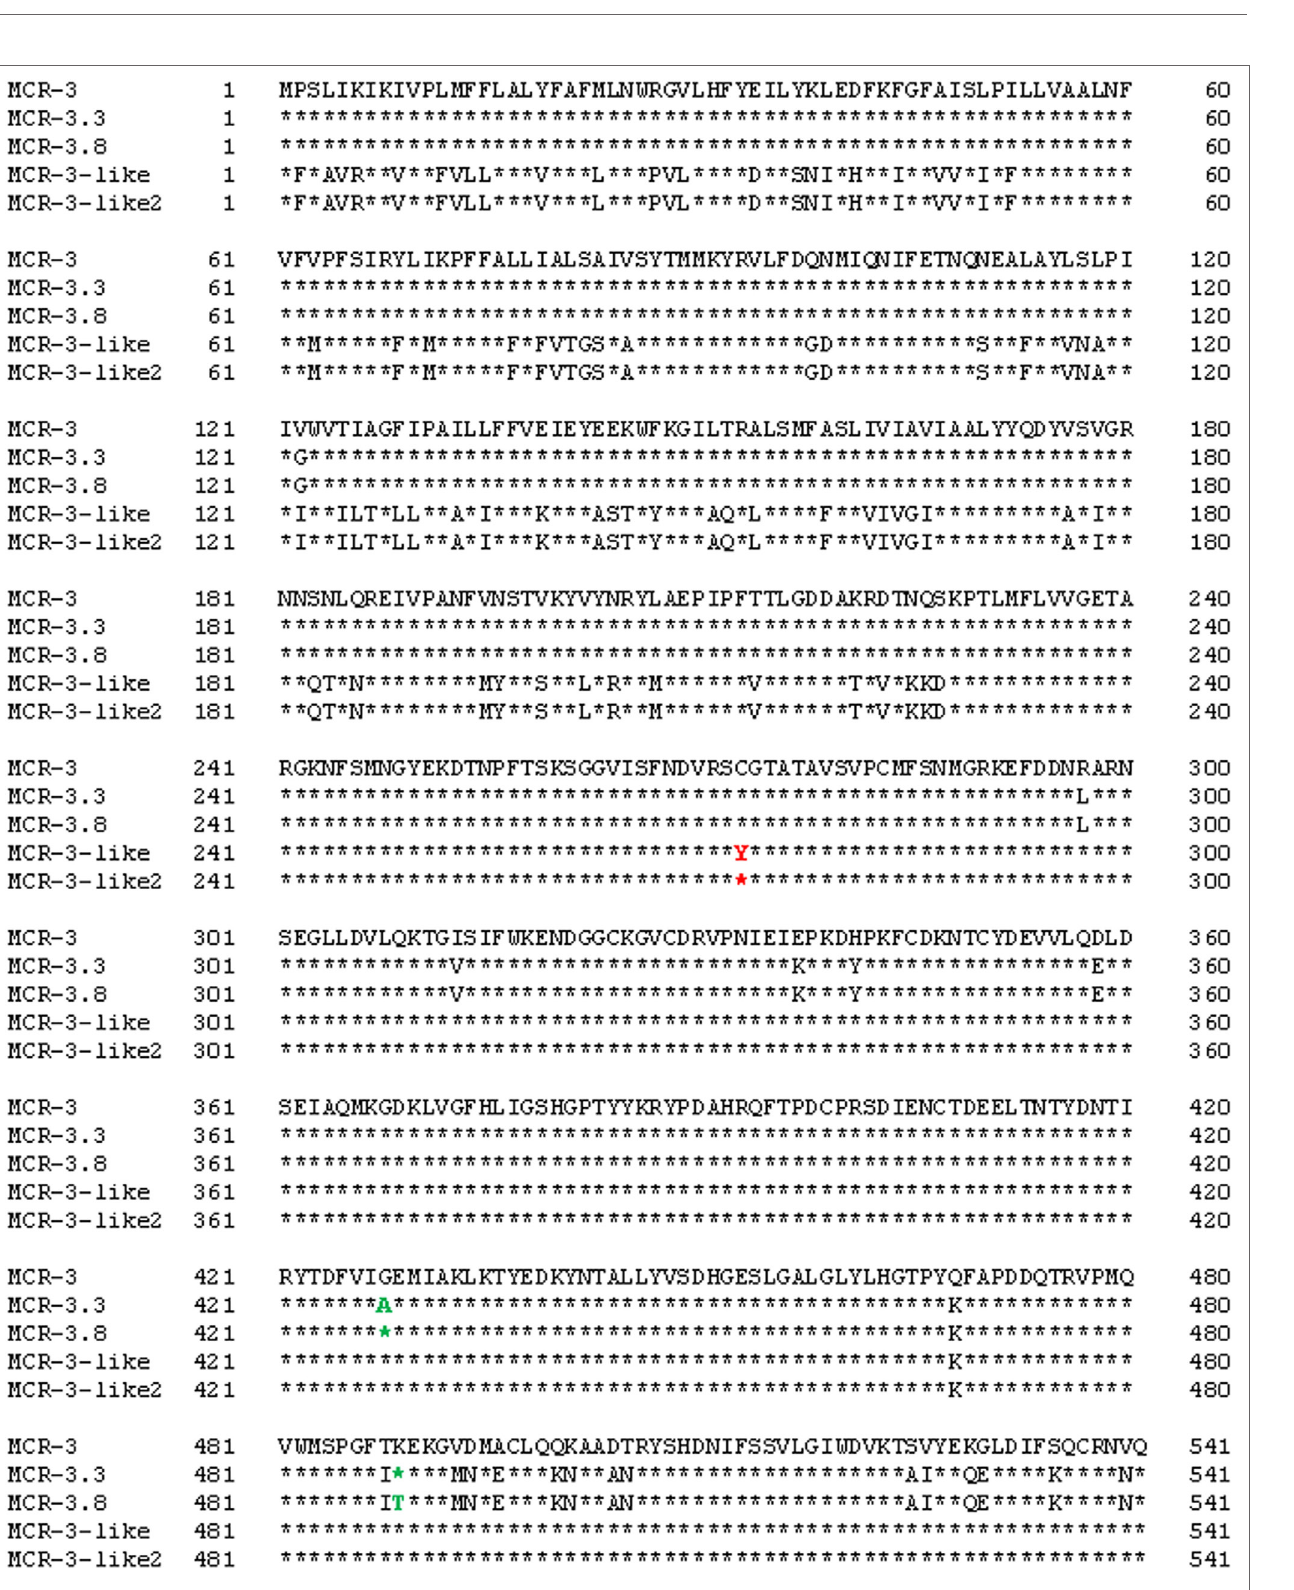
FigUre 2 | Alignment of the MCR-3, MCR-3.3, MCR-3-like, MCR-3.8, and MCR-3-like2 sequences from Escherichia coli (GenBank accession no. KY924928) and Aeromonas isolates (GenBank accession no. MF495680 and